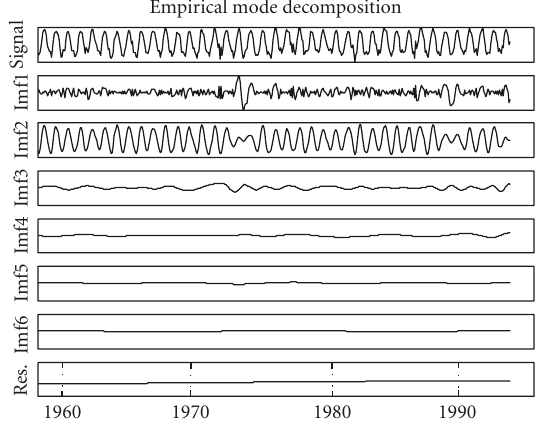
Figure 6: Decompose results by straightforward EMD for averaged air temperature.